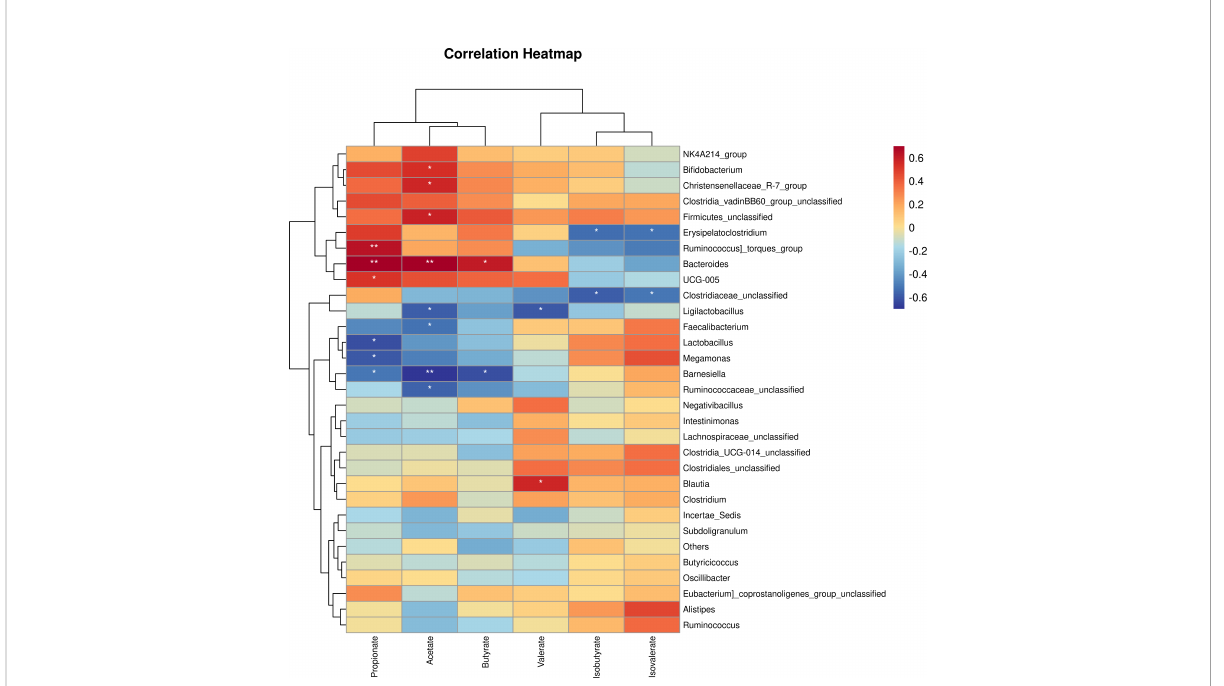
FIGURE 9 The correlation analysis between caecal microbial genus and short chain volatile fatty acid production in EP+YG treated vs control chickens. * P < 0.05 and ** P